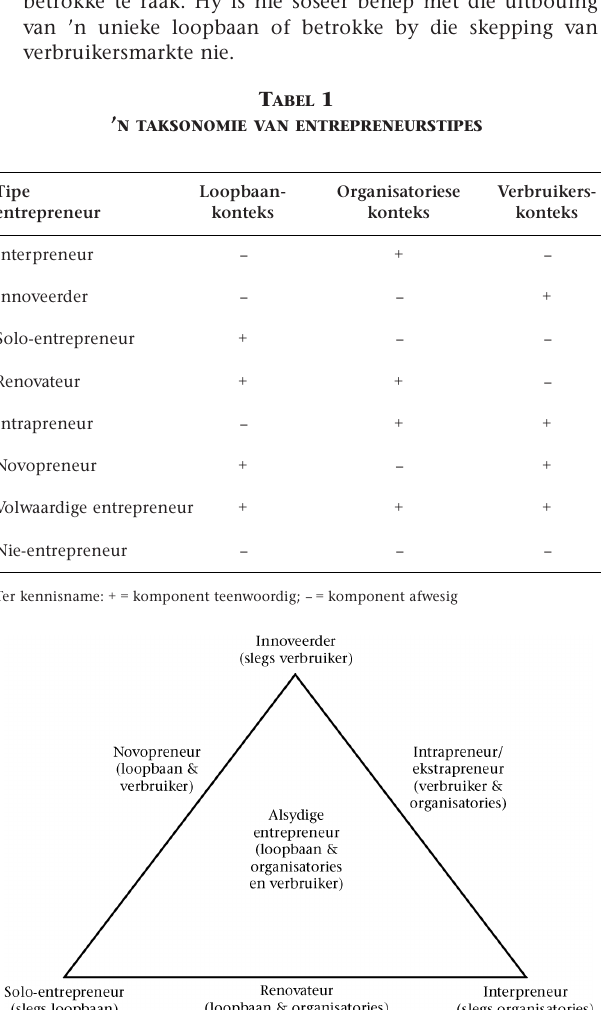
Figuur 6: ’n Grafiese voorstelling van die dinamies- veranderende herhalende patroon van entrepreneurskap Sternberg (1987) in sy studie van die liefde toon aan dat die struktuur van ’n driehoek dit moontlik maak om soorte van ’n verskynsel te klassifiseer. ’n Uiteensetting hiervan vir entrepreneurskap word vervolgens gegee.